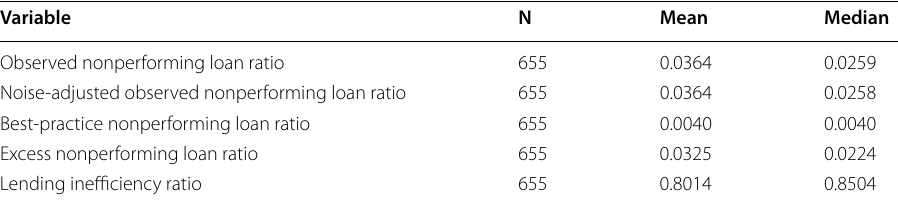
Table 8 2013 unsecured consumer loans. Excluding the volume of unsecured consumer lending. Summary statistics of nonperformance derived from stochastic frontier